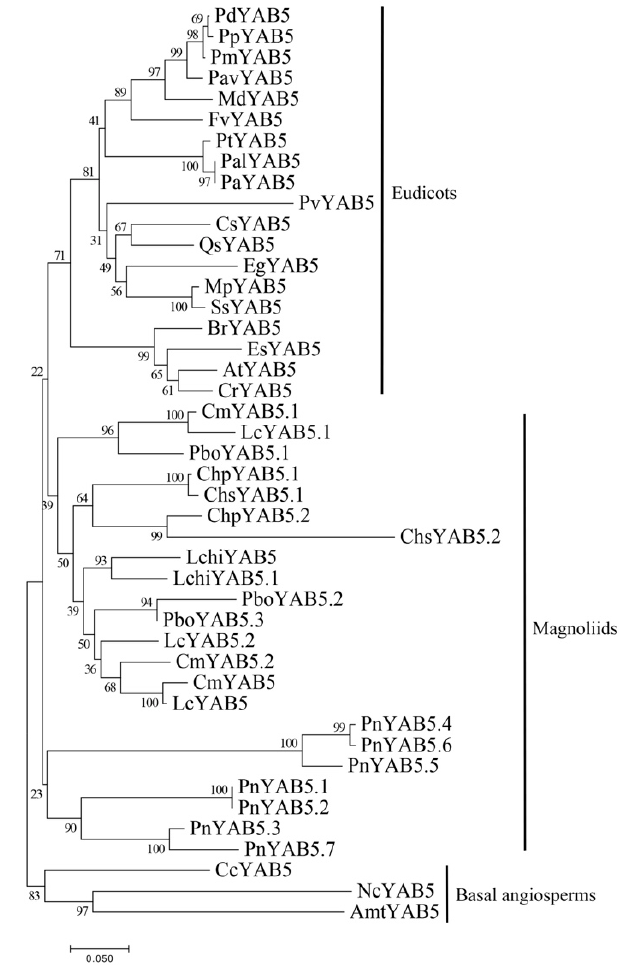
Figure 8. Phylogenetic tree of YAB5 proteins from various angiosperms. The phylogenetic tree was constructed with the NJ method using MEGA 7.0 software. Bootstrap analysis was conducted with 1000 replications. The same acronym represents the same species: Cm: C. micranthum ; Chp: C. praecox ; Lc: L. cubeba ; Chs: C. salicifolius; Pbo: P. bournei ; Pn: P. nigrum ; Lchi: L. chinense . The protein accession list for related proteins is collected in Table S1.